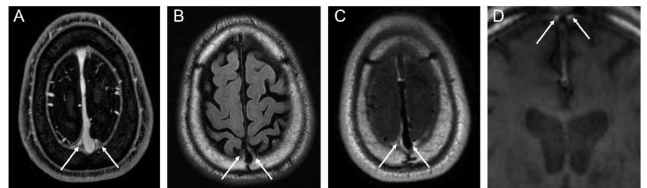
Figure 2. MRI visualization of peri-sinus lymphatic space on conventional contrast-enhanced axial T1-weighted image ( A ), axial FLAIR image ( B ), contrast-enhanced axial T1-weighted black-blood image ( C ), and coronal T1-weighted black-blood image ( D